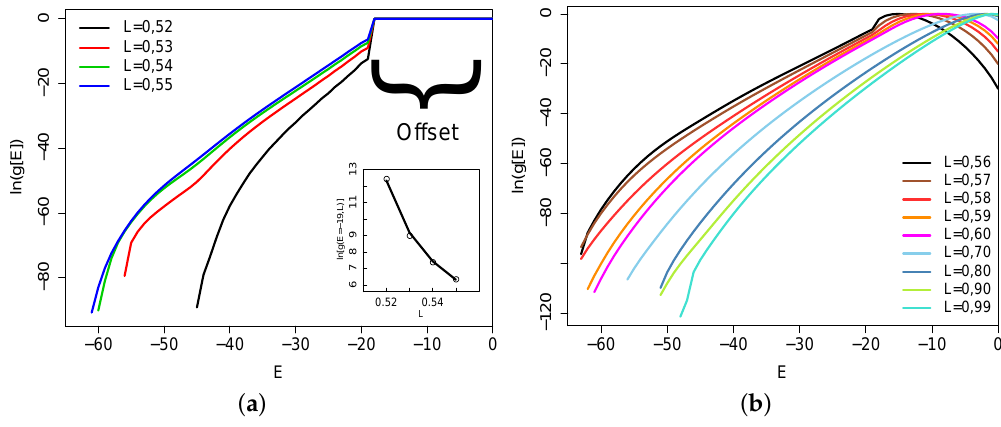
Figure 2. ( a ) shows the micro-canonical entropy for the stiff chains (note that, for N = 20, we only studied bond lengths larger than 0.51); ( b ) for the semi-flexible chains. Note the shift in the energy spectrum in the stiff case due to the permanent overlap of interaction zones of next-nearest neighbors along the chain. The inset shows the jump at the step in ln [ g ( E )] and a fit with the law ( L − 0.5 ) − 3/4 . For the stiff chains (0.52 ≤ L ≤ 0.55), there is a jump in the density of states at E = − 18,